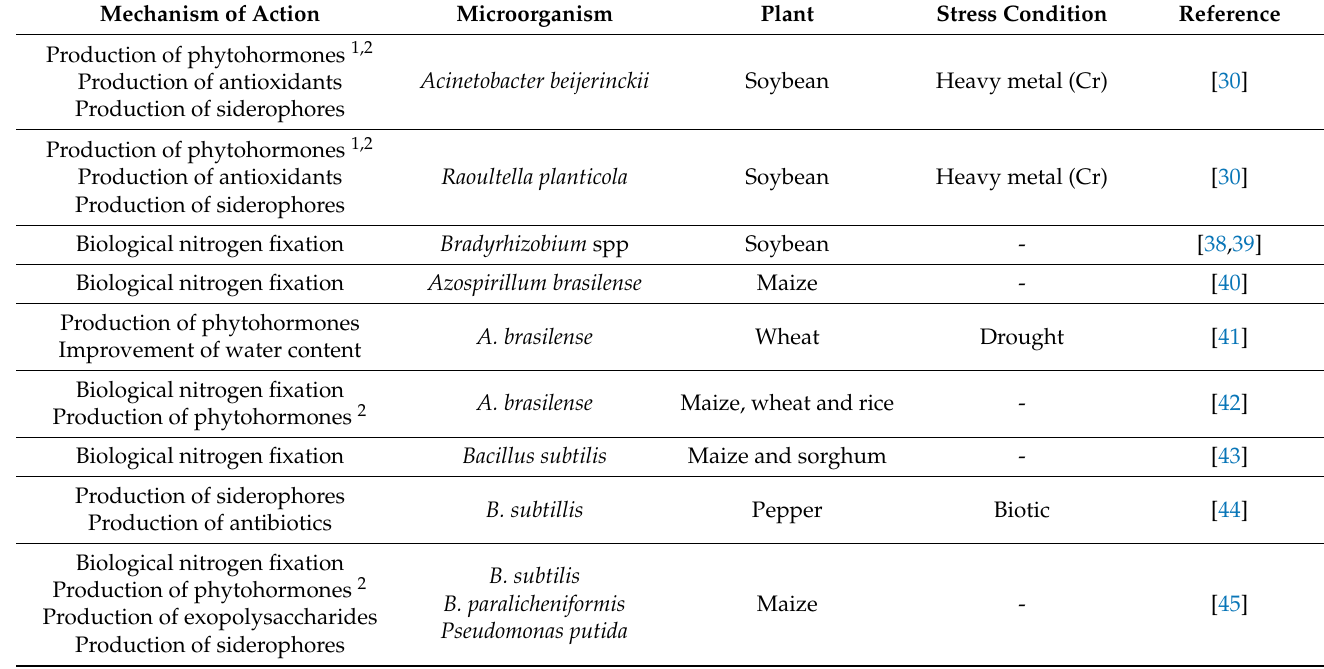
Table 1. Examples of PGPB mechanisms of action under different stresses and their improvement of plant